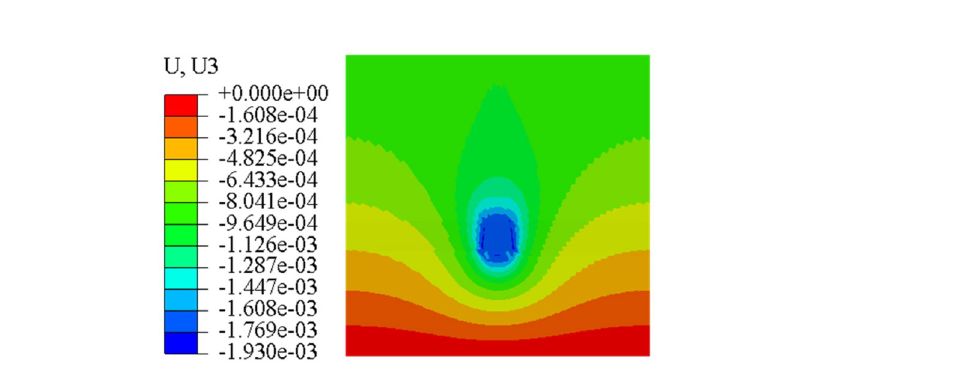
Figure 27. Top 800 mm, bottom 1000 mm anchor pier stress nephogram.